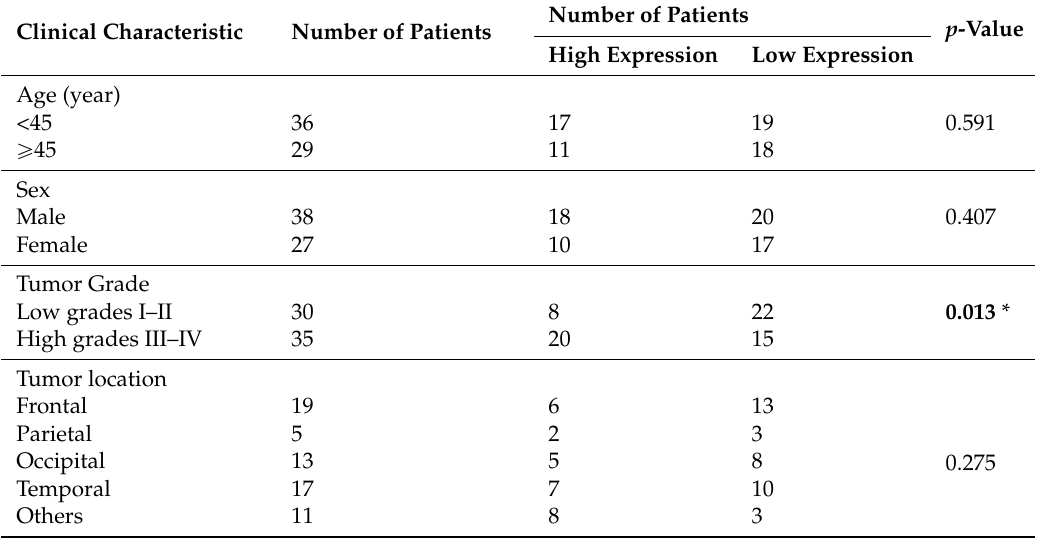
Correlation of lncRNA AB073614 expression with clinicopathological features in glioma patients.